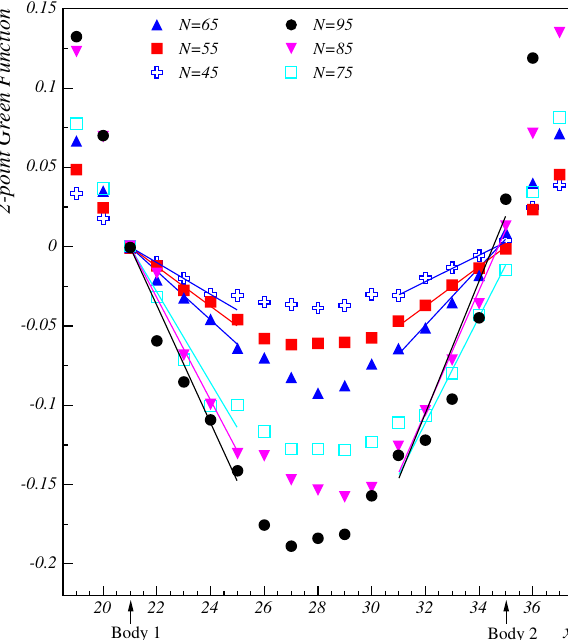
Fig. 18 Same as Fig. 17 but with the free-field potential subtracted. The line segments illustrate the nearly linear trend of the potential measured a few nodes away from the sources (e.g. around x = 21 and x = 35 in Fig. 18). The free massless field − field contribution G free 2 p